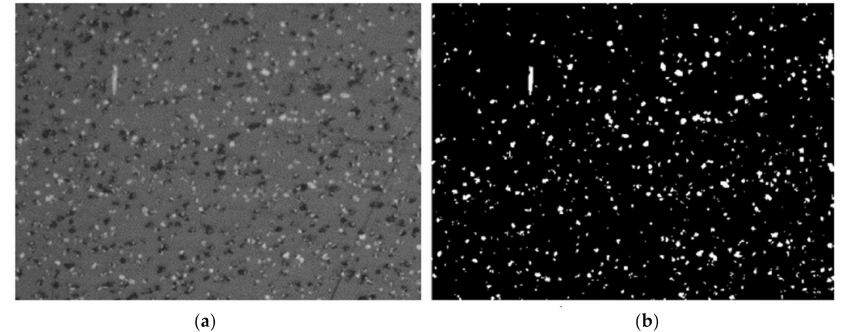
Figure 9. Pixel conversion to white / black. ( a ) original, ( b ) converted.